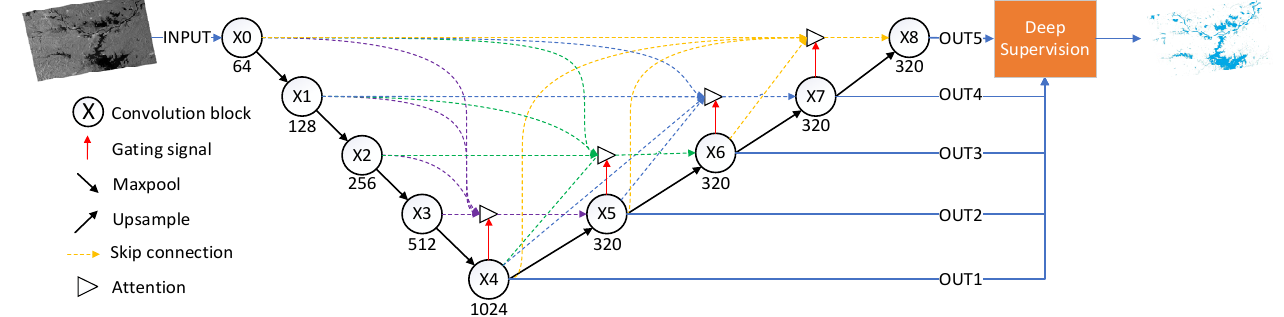
Figure 3. Attention-UNet3+ architecture.